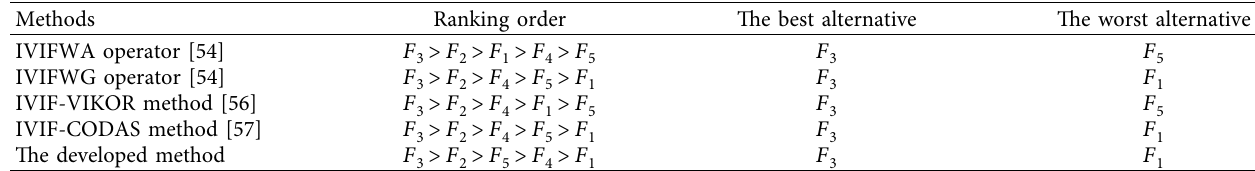
Table 6: Evaluation results of these